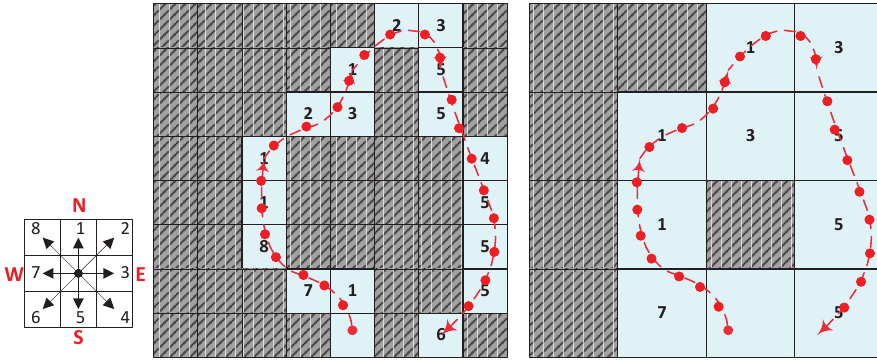
Figure 4. Trace coding projects a raw moving trace to a grid-based 8-directional chain coded